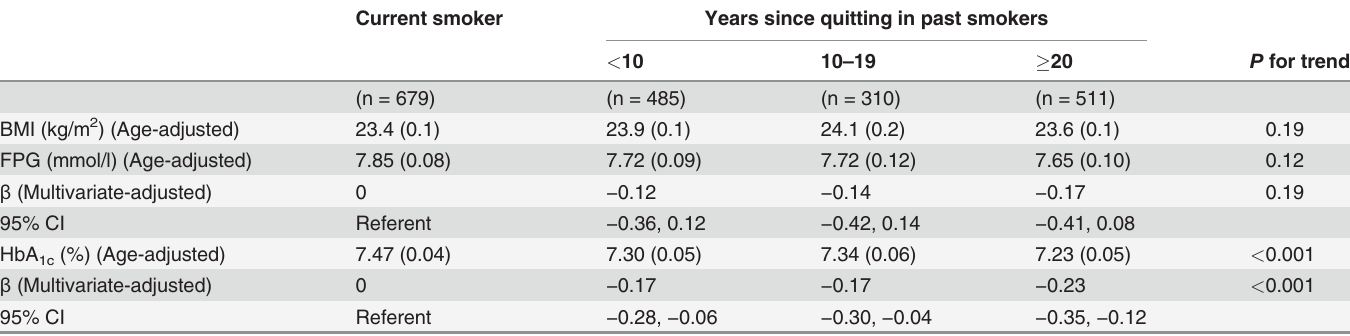
Table 4. Age-adjusted mean values of BMI, FPG and HbA 1c and multivariate-adjusted partial regression coefficients (95% CIs) of FPG and HbA 1c according to the years since